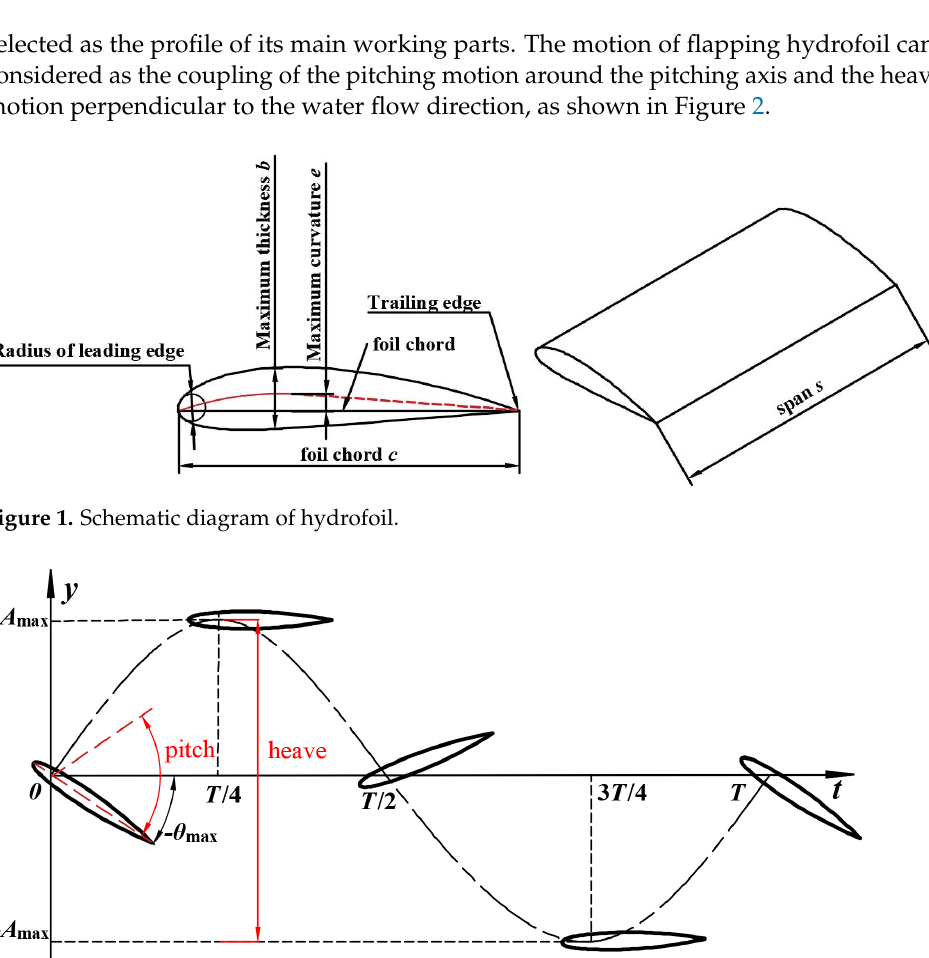
Figure 2. Schematic diagram of flapping hydrofoil movement.